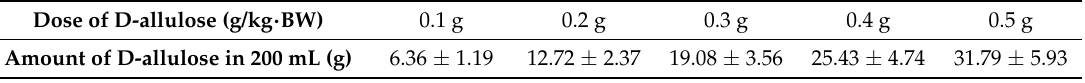
Table 1. Dose of sucrose or D-allulose included in the test drinks for occasional ingestion. Dose of D-allulose (g/kg · BW) Amount of D-allulose in 200 mL Dose of